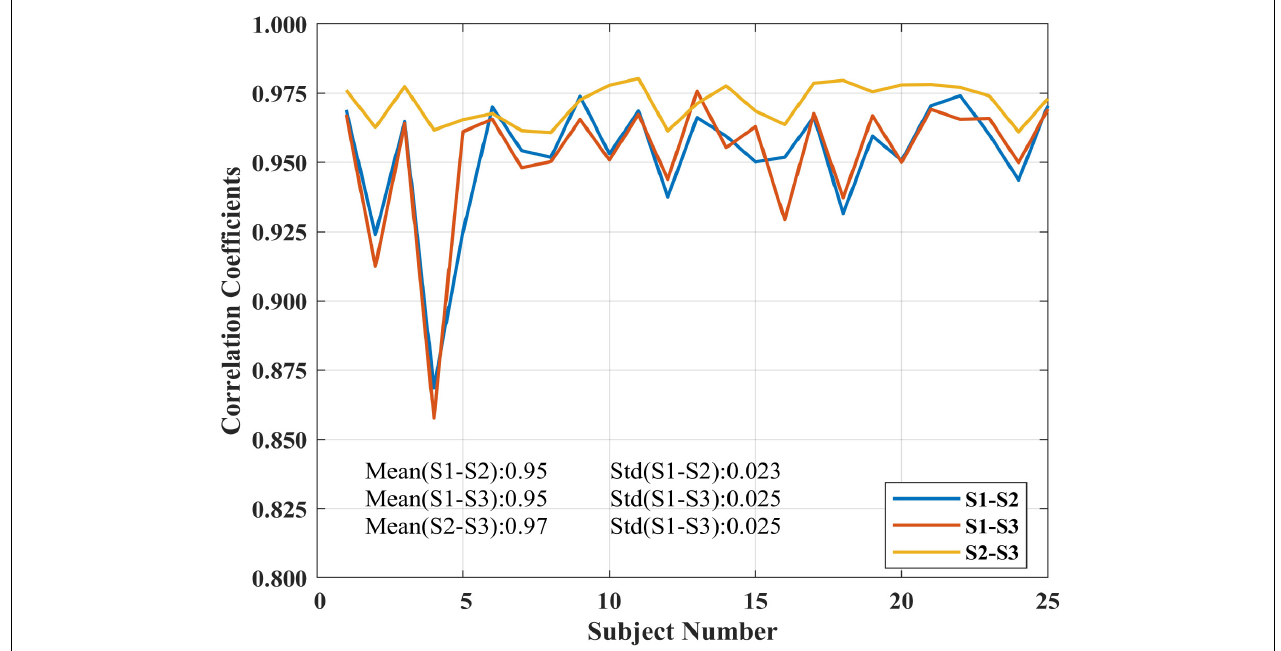
FIGURE 5 | Correlation coefficients of SCM maps among three sessions for 25 subjects in the test-retest resting-state